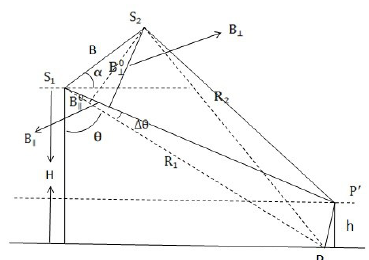
Figure 2.Geometric relationship of radar interference 2